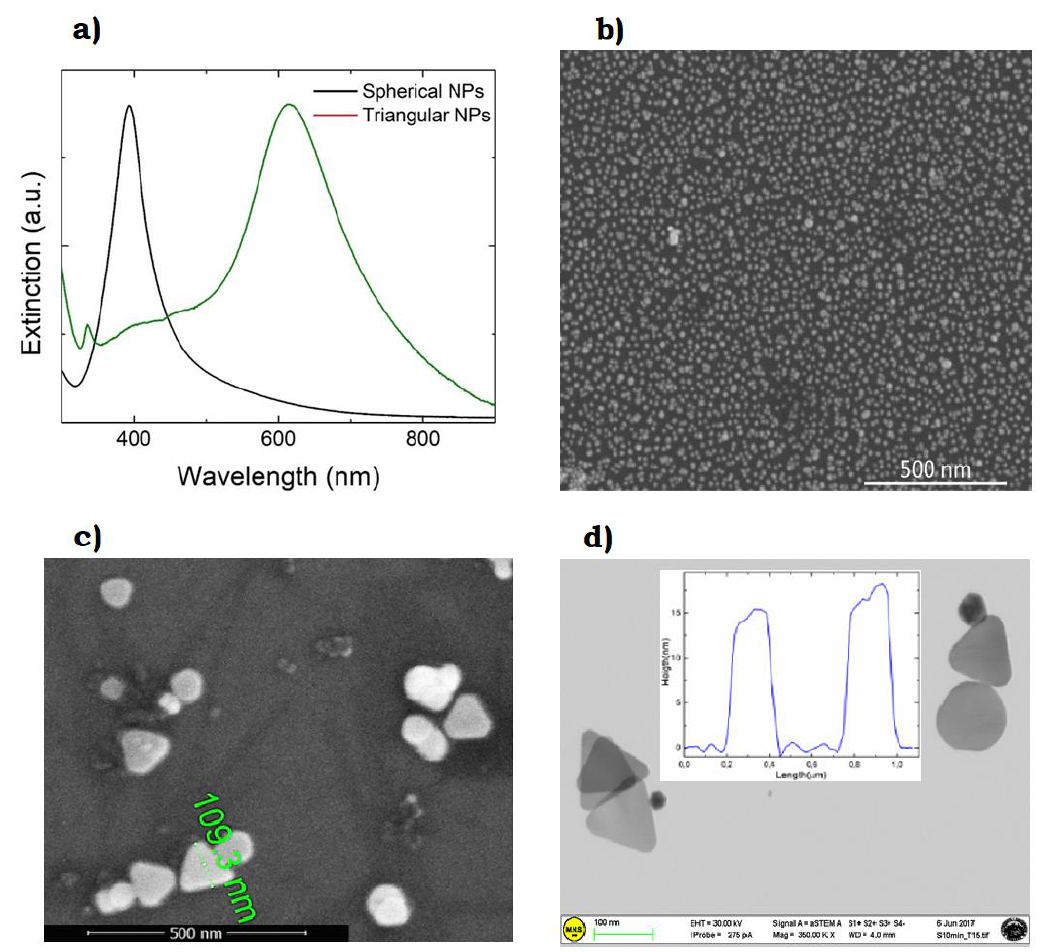
Figure 15. Optical absorption spectra of spherical vs triangular silver NPs ( a ); SEM image of spherical NPs ( b ) and of triangular nanoparticles ( c ) TEM image and in the inset AFM profiles of triangular NPs ( d ). Reprinted from Ref. [156], Copyright (2019), with permission from Elsevier.